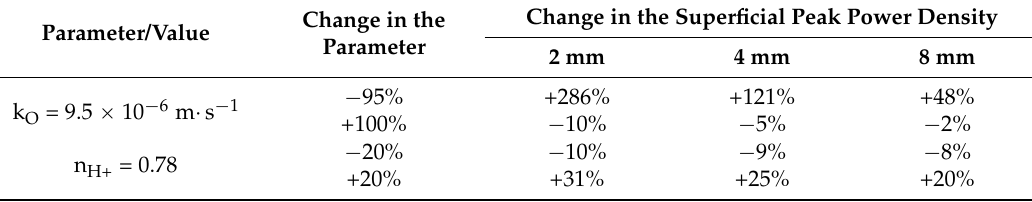
Table 3. Percentage change in the superficial peak power density of the FPMFCs with one at a time change of the characteristics of